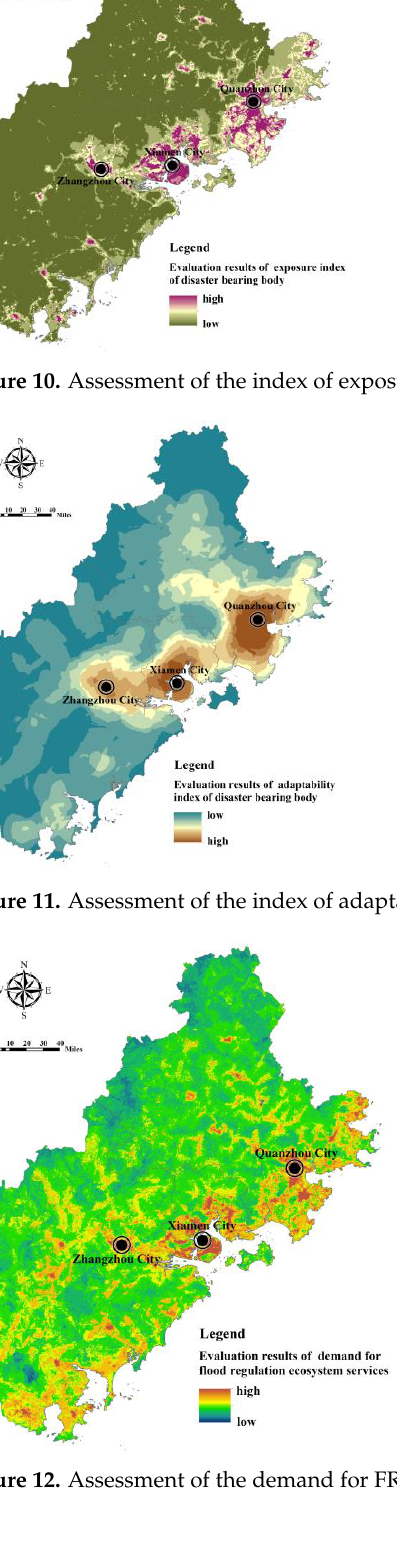
Figure 12. Assessment of the demand for FRES in Fujian Delta.